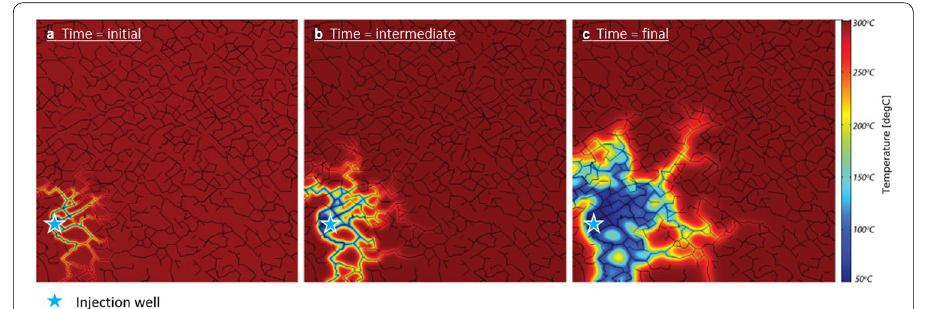
Fig. 7 Example of simulation with connected fractures and high fracture aperture